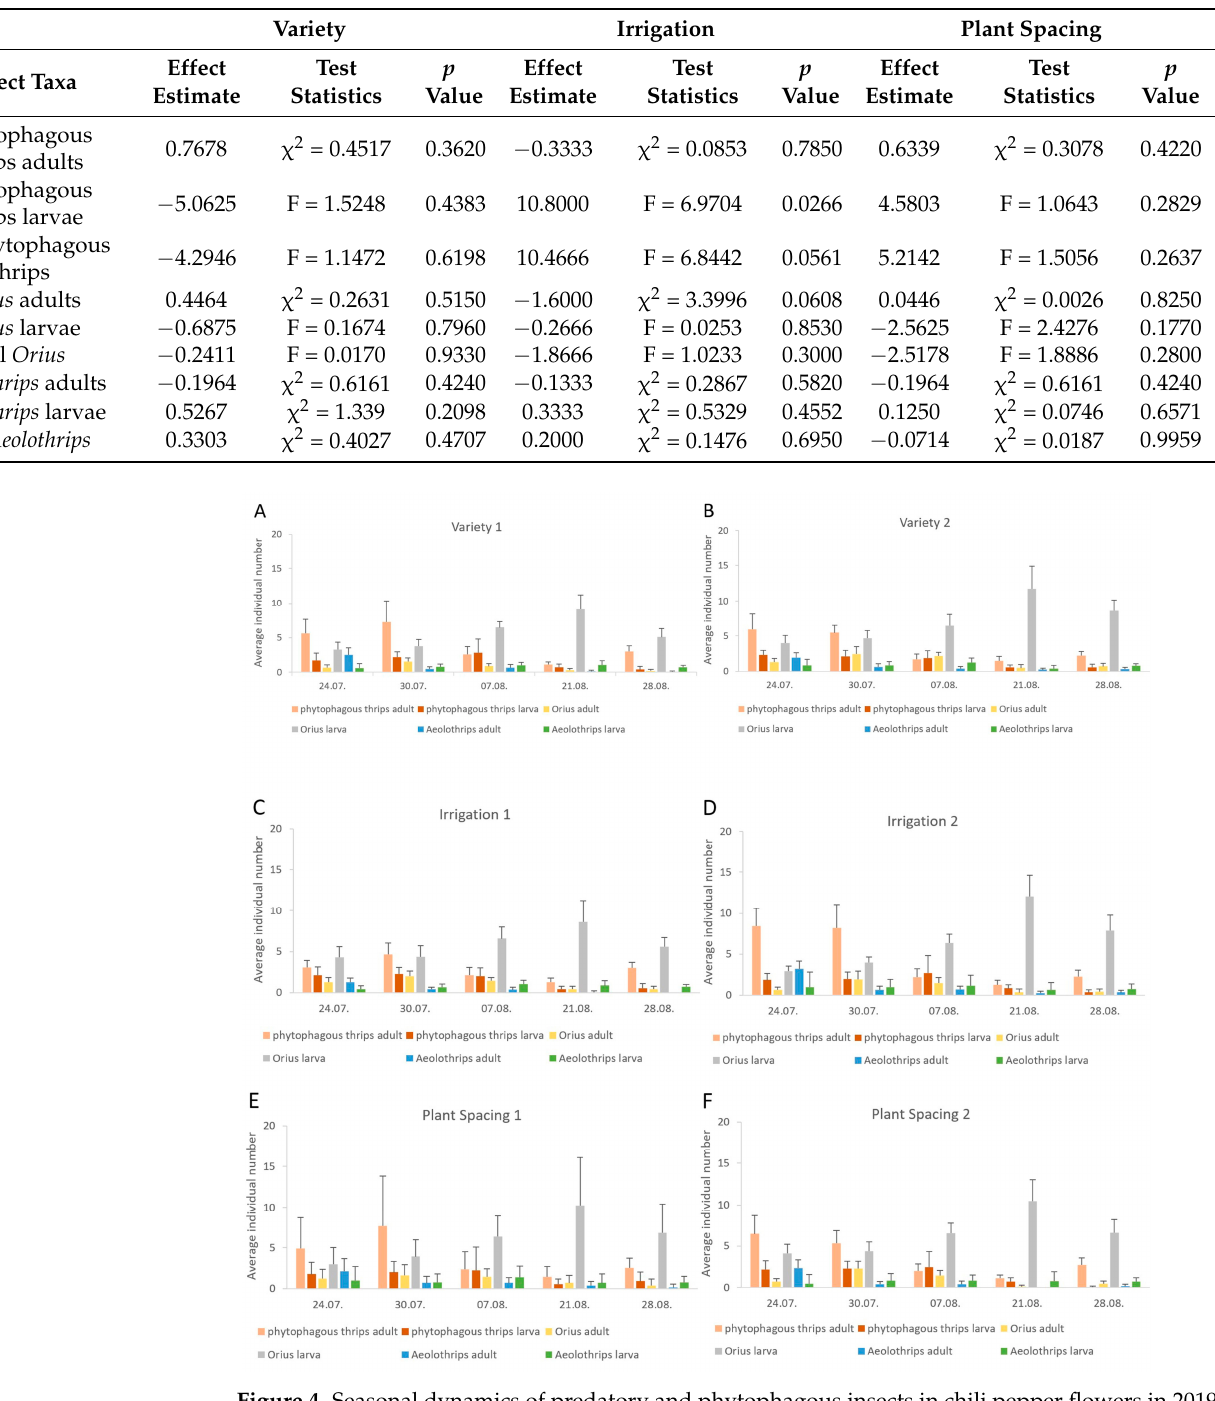
Figure 4. Seasonal dynamics of predatory and phytophagous insects in chili pepper flowers in 2019. ( A ) Trinidad Scorpion Butch T. ( B ) Yellow Scotch Bonnet. ( C ) Irrigation daily, 40 min. ( D ) Irrigation every second day, 20 min. ( E ) Increased plant spacing. ( F ) Decreased plant spacing. The error bars represent the standard errors.